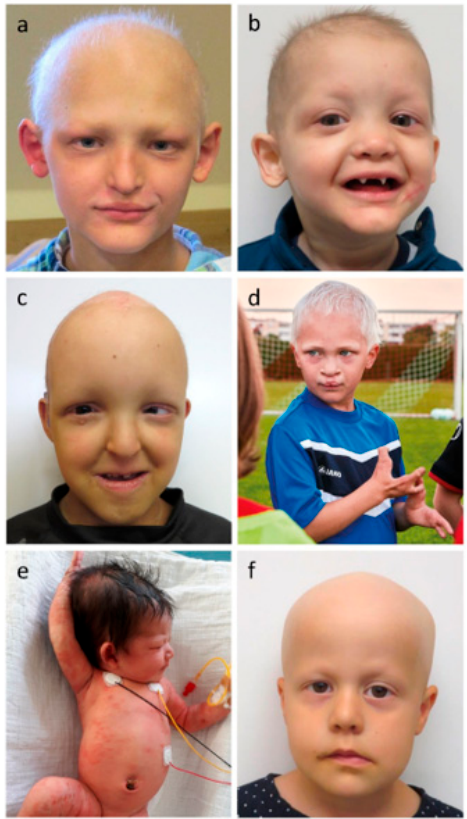
Figure 1. ( a , b ) Hypohidrotic ectodermal dysplasia due to pathogenic EDA variants (XLHED). Note